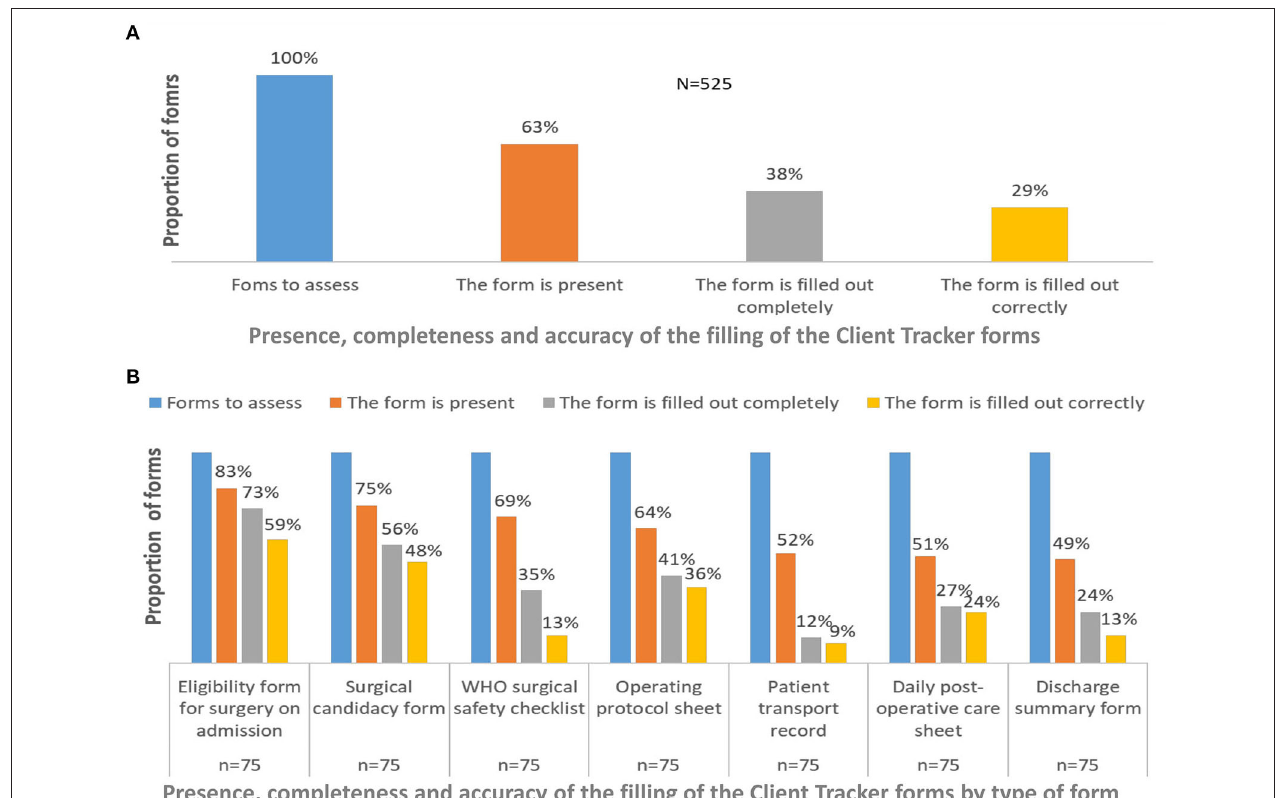
FIGURE 2 | Client Tracker use by type of form in female genital fistula management at Fistula Care Plus Sites, DR Congo,